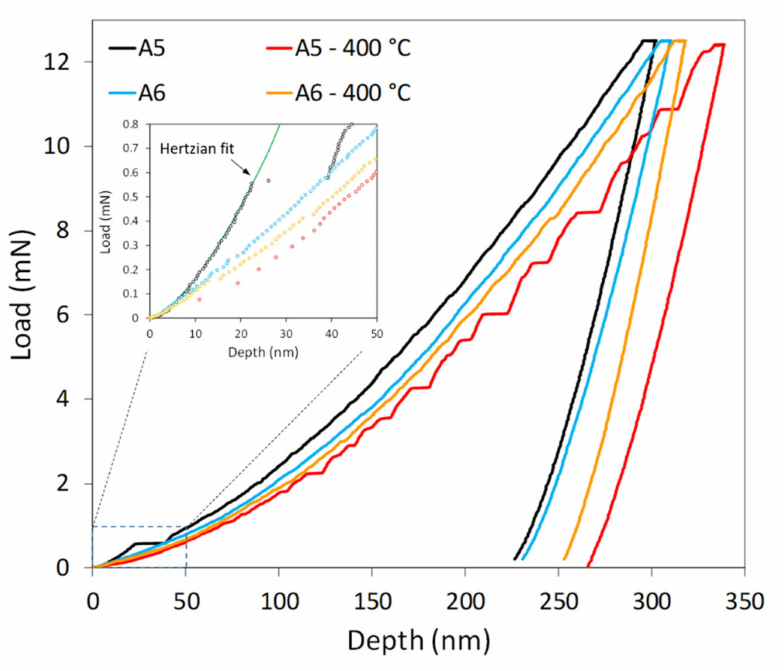
Figure 8. Load–depth curves measured at room temperature (RT) and 400 ◦ C of SPS samples A5 and A6 sintered at 100